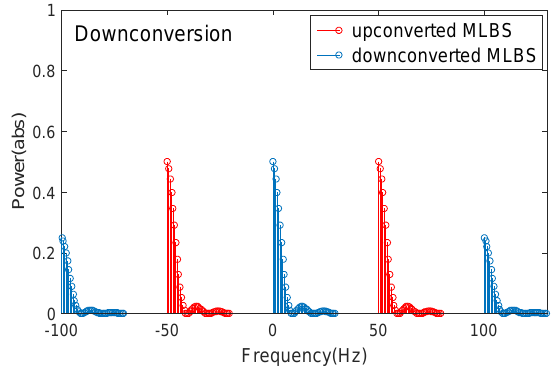
Figure 5: MLBS with 50 Hz downconversion. The form of the modulation is known as double side- band modulation because the excitation is